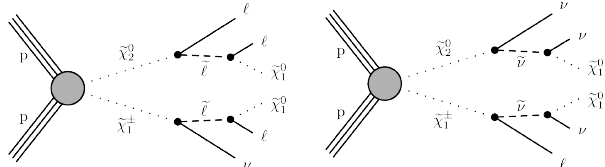
Figure 11: Chargino and neutralino pair production with decays mediated by slep- tons and sneutrinos [ 20 ] .